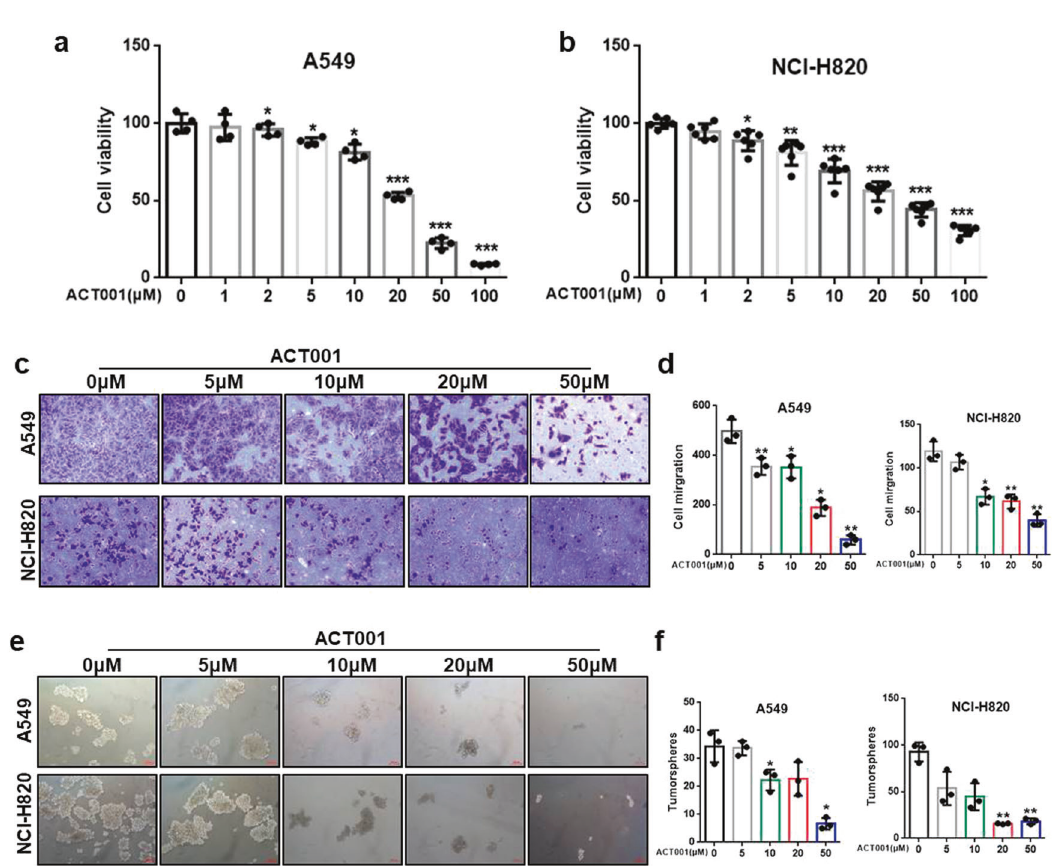
Fig. 4 ACT001 diminished lung cancer cell stemness. a , b The effect of ACT001 on the viability of A549 and NCI-H820 cells for 48 hours. c , d Representative images and number of A549 and NCI-H820 migrated cells after treatment of ACT001 at indicated concentrations, n = 3. e , f Representative images and number of A549 and NCI-H820 tumorspheres after treatment of ACT001 at indicated concentrations, n = 3. The data were presented as the mean ± SD, * p < 0.05, ** p < 0.01, *** p < 0.001. body length, tail length, nest weight, mean fetal weight, or placental weight between ACT001 groups and vehicle control group (Fig. S1d), indicating that ACT001 had no impact on embryo-fetal growth or development. Furthermore, Ames test were conducted to examine whether ACT001 had potential mutagenic effects, the results showed that ACT001 displayed negative characteristics within the concentration range of 0.125 μ g/dish~1250 μ g/dish in mutagenicity test against strains